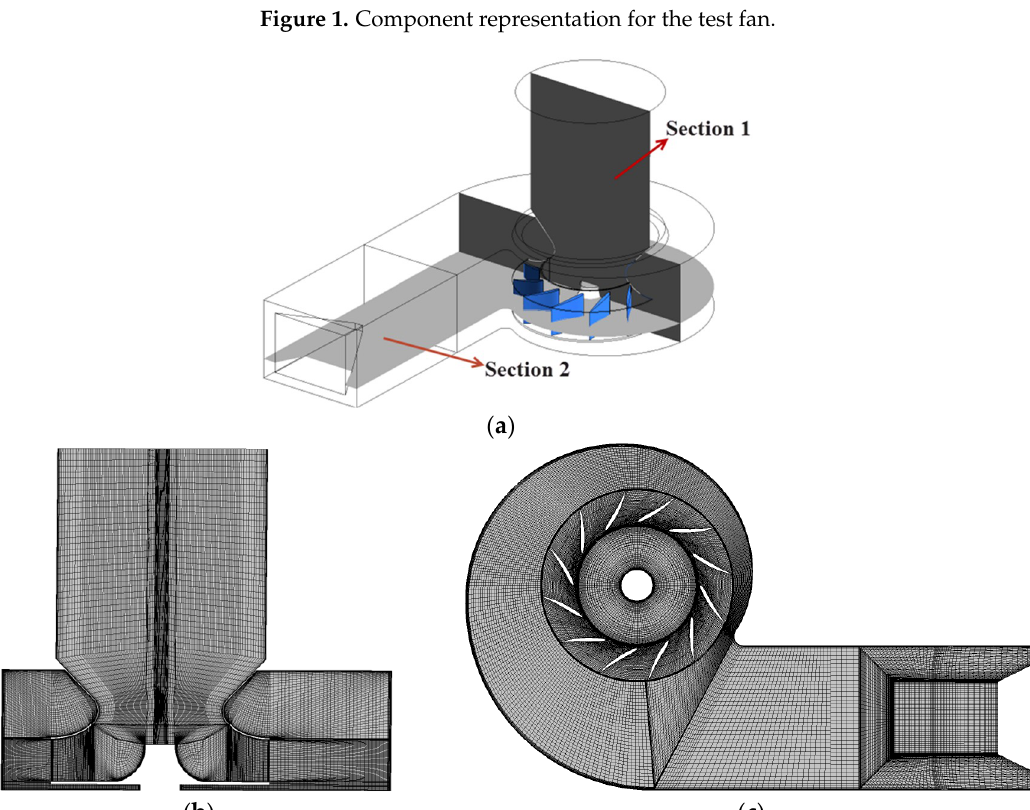
Figure 2. Mesh details of fan. ( a ) Section workspaces; ( b ) Mesh details of Section 1; ( c ) Mesh details of Section 2.